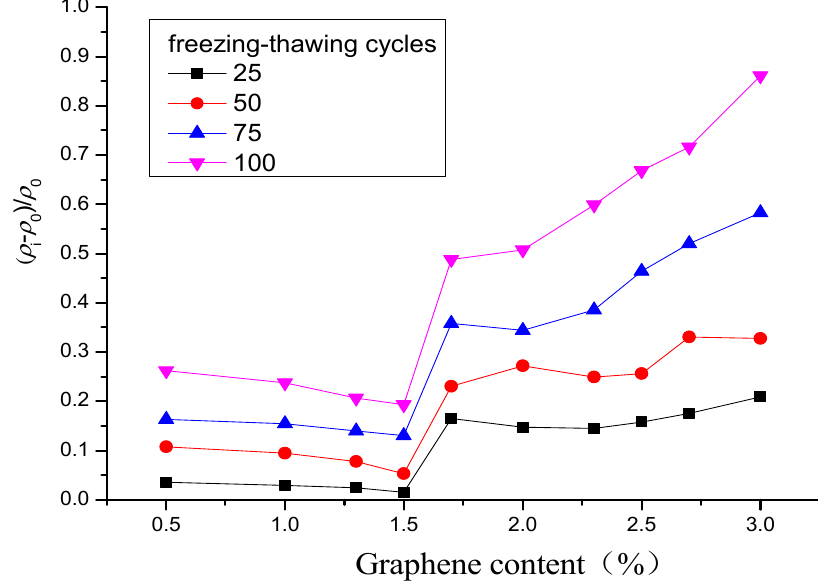
Figure 5. Relative change rate of electrical resistivity after different freeze–thaw cycles.